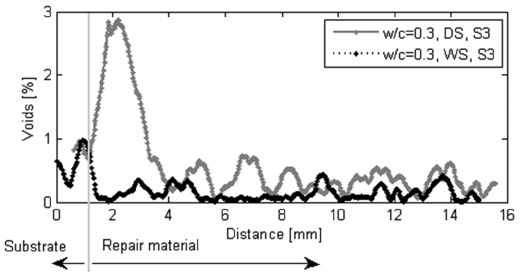
Figure 17. Void content in the repair system close to the interface (influence of the substrate saturation).